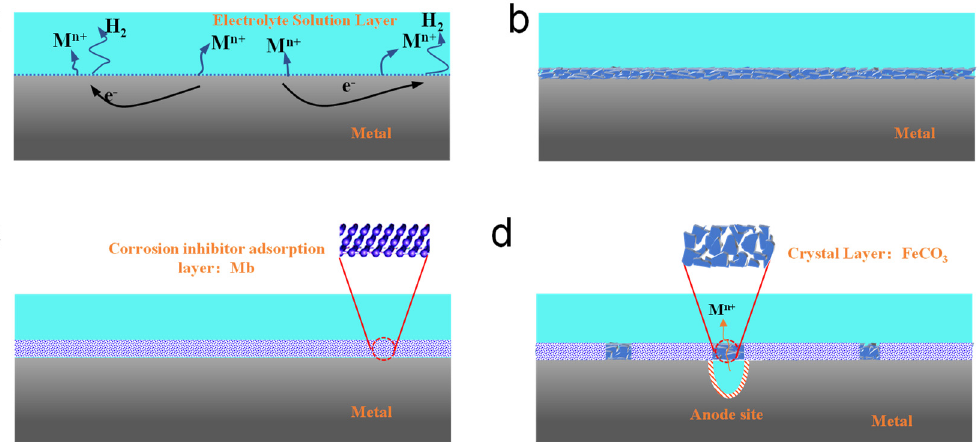
Figure 9. Corrosion/corrosion inhibition mechanism model diagram: ( a ) fresh acid; ( b ) residual acid; ( c ) fresh acid with Mb; ( d ) residual acid with Mb.